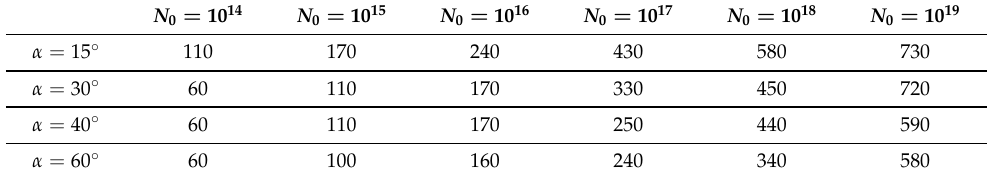
Expected yearly number of lightning strokes taking place within the detectability regions identified for different configurations of half-angle α and initial number of gamma-ray photons N 0